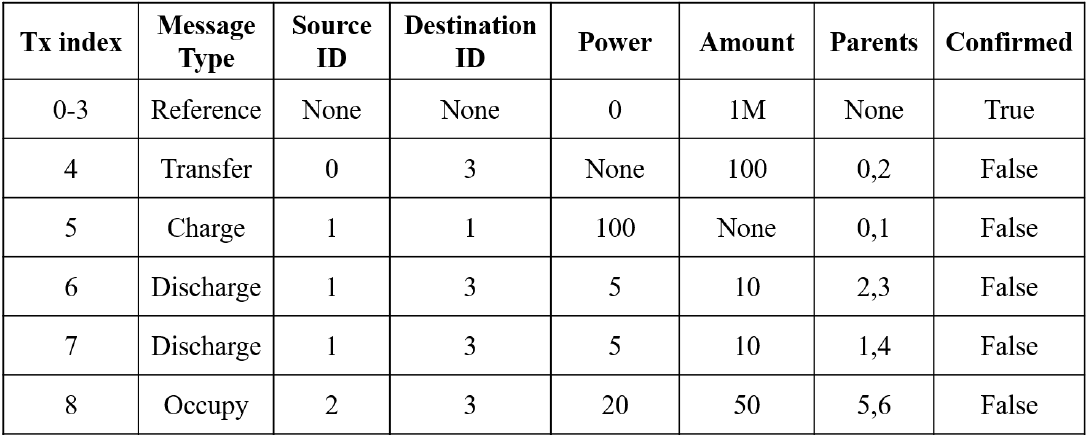
Figure 2. PowerGraph sample